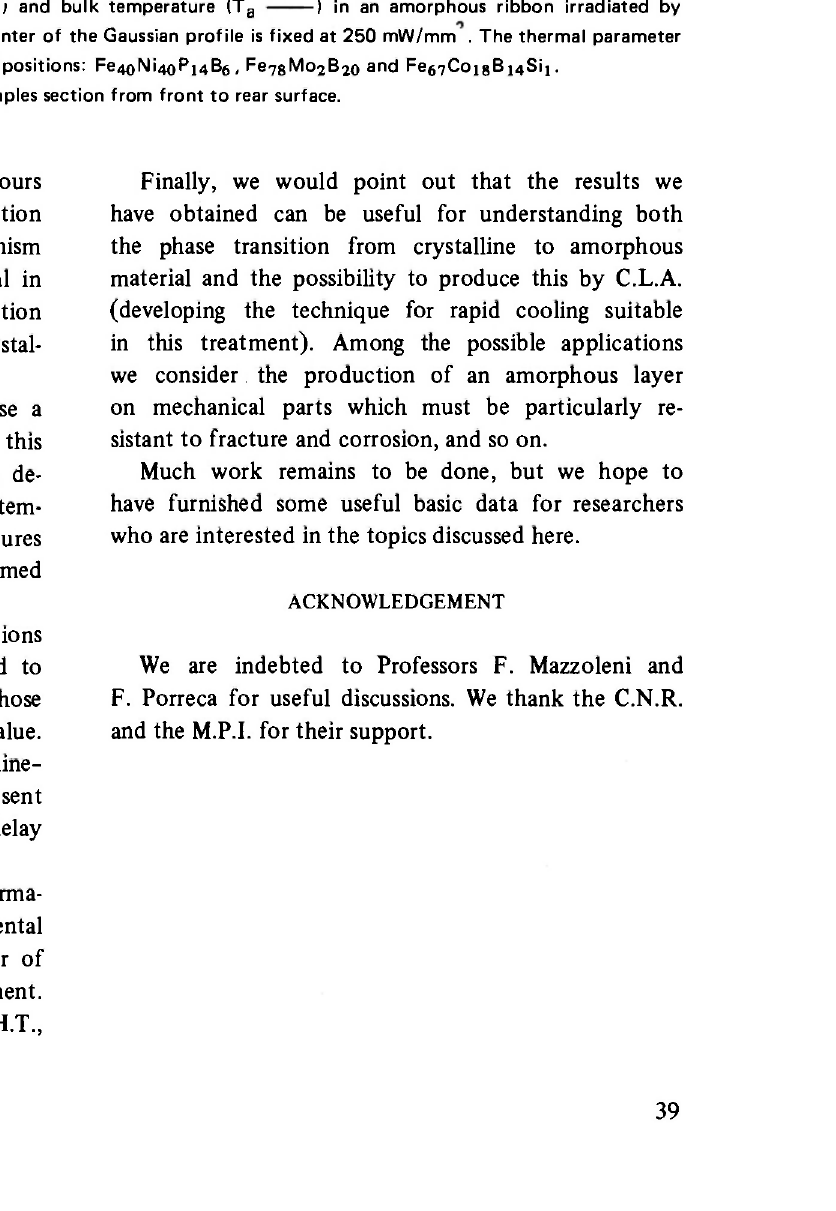
Fig. 20. (a) Behaviour of surface temperature (T s and bulk temperature (T a -) in an amorphous ribbon irradiated by laser, when the specific energy absorbed in the center of the Gaussian profile is fixed at 250 mW/mm . The thermal parameter values were averaged from those of the typical compositions: Fe4oNi4oPi4B6 , Fe78Mo2B;;o and Fe^CoieB^Sii. (b) Expected temperature behaviour across the samples section from front to rear